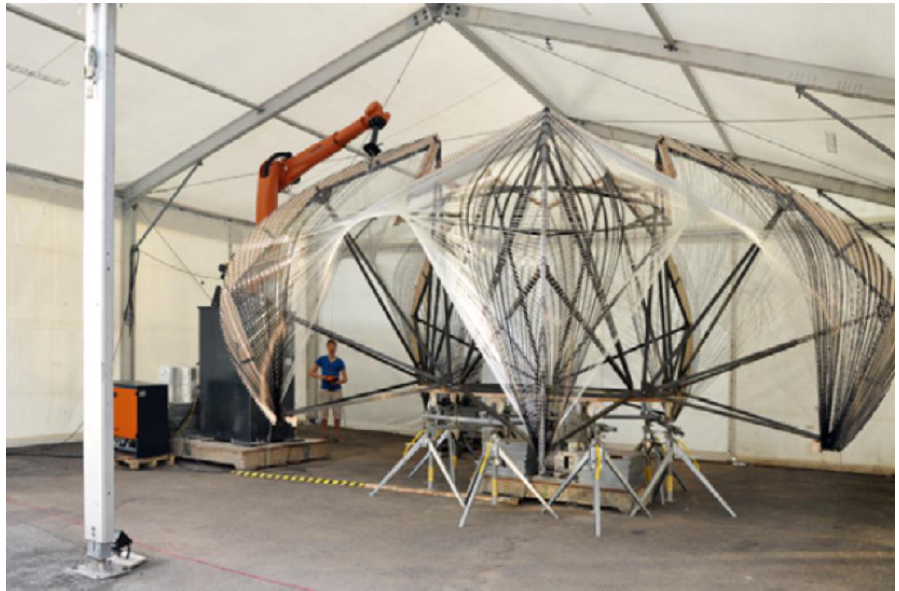
Figure 2. Architectural scale prototype of engineered structure demonstrating biomimicry design principle of lobster shell structure using fibrous composite materials assembled through robotic fabrication [57].